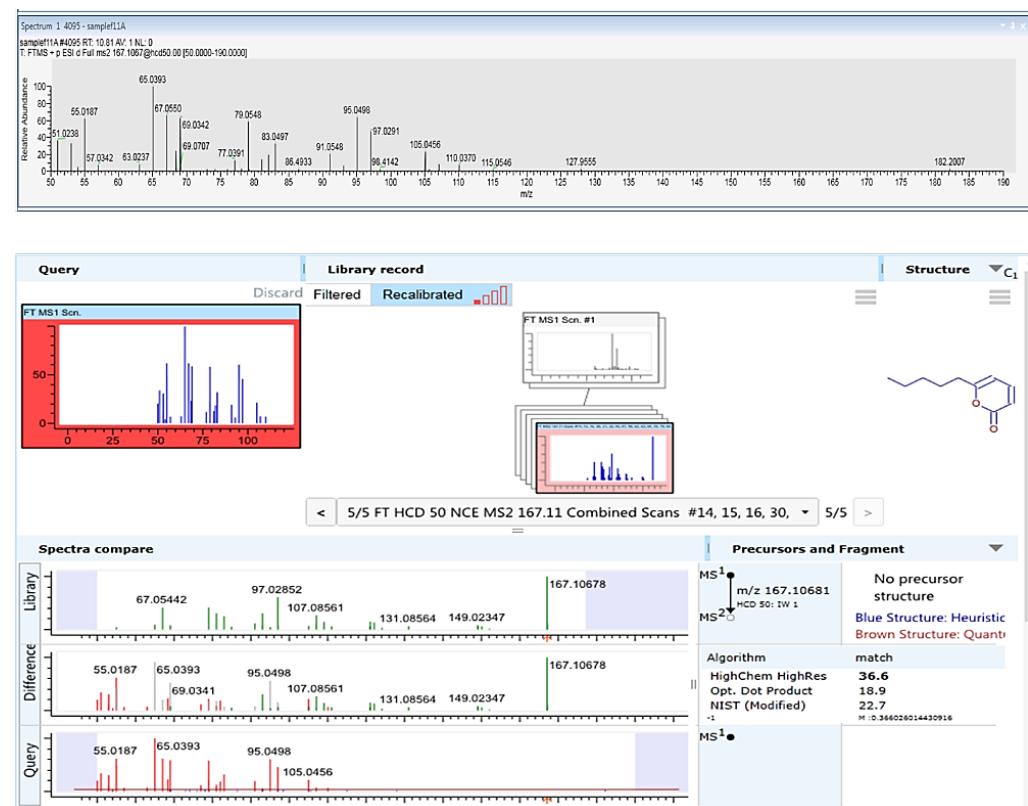
Figure 5. Identification of Trichoderma asperellum (P1) active ingredient(s) using LC–MS/MS analysis.